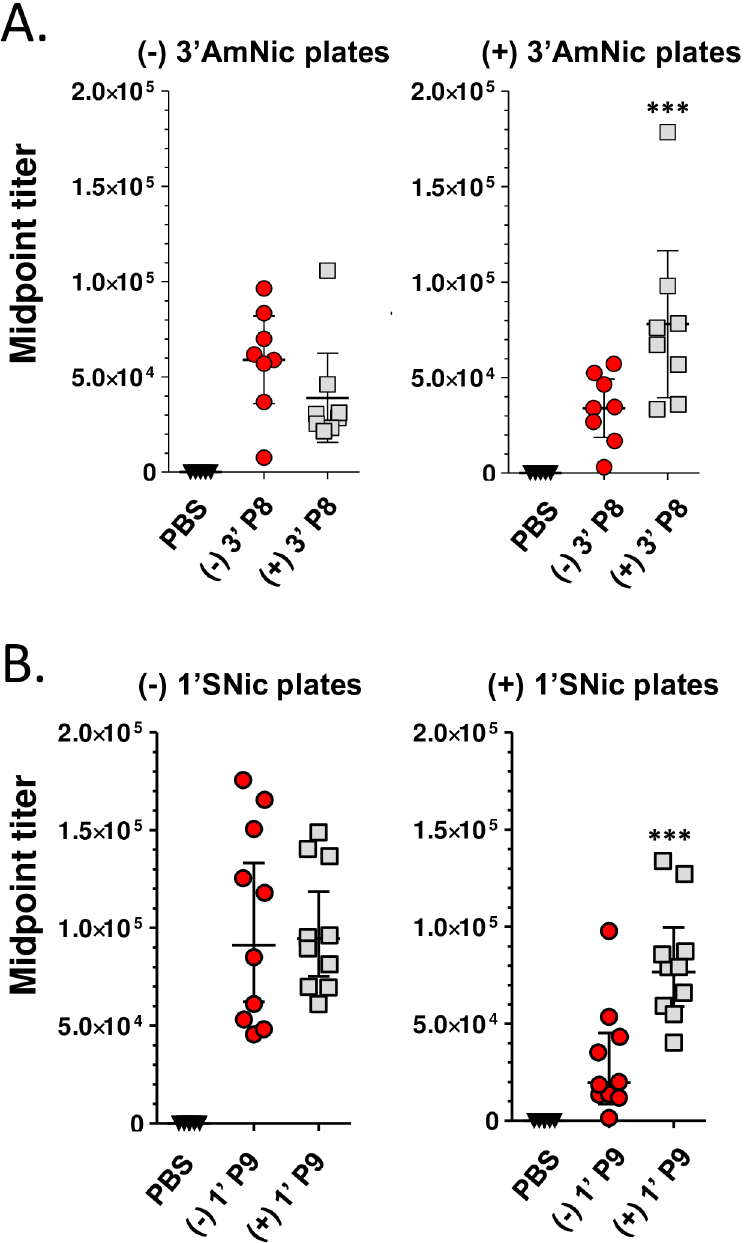
Fig 2. Antibody titers induced by enantiopure 3’-AmNic and 1’-SNic haptens. CD-1 female mice (n = 8) receiveda prime boost boost immunization with either P8 peptide(5 µ g) conjugated to (-) 3’ or (+) 3’AmNic haptens(A); or with P9 peptide(5 µ g) conjugated to (-) 1’ or (+) 1’SNic haptens(B). Serum was collected56 days later and assayed by ELISA using plates coated with the reciprocal enantiopure haptens conjugated to BSA. Comparisons betweengroups were conductedby unpairedt-test. *** p < 0.001. from 1/100 in blocking buffer. Midpoint titers at half maximal absorbance were calculated using GraphPad Prism (GraphPad Software, San Diego, CA). Ab affinities were determined as previously reported [37] with the following modifications. Nicotine was prepared at 200 mM and serially diluted to 0.2 nM in blocking buffer. 80 µL of sera (diluted to a concentration